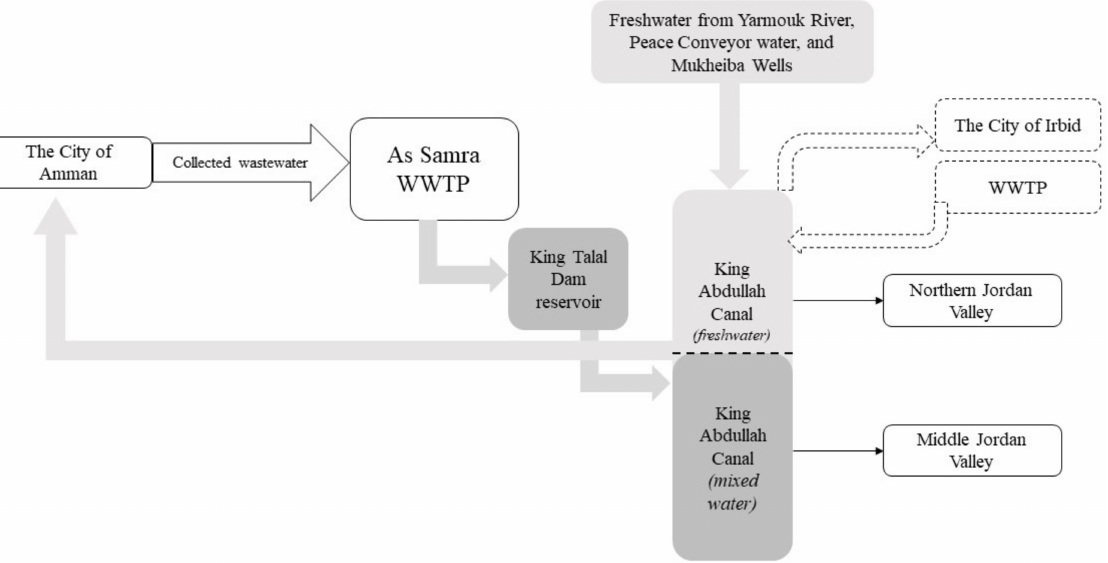
Figure 3. Current and proposed water reallocation plans in the Jordan Valley (dashed lines indicate proposed water reallocation scheme). WWTP = wastewater treatment